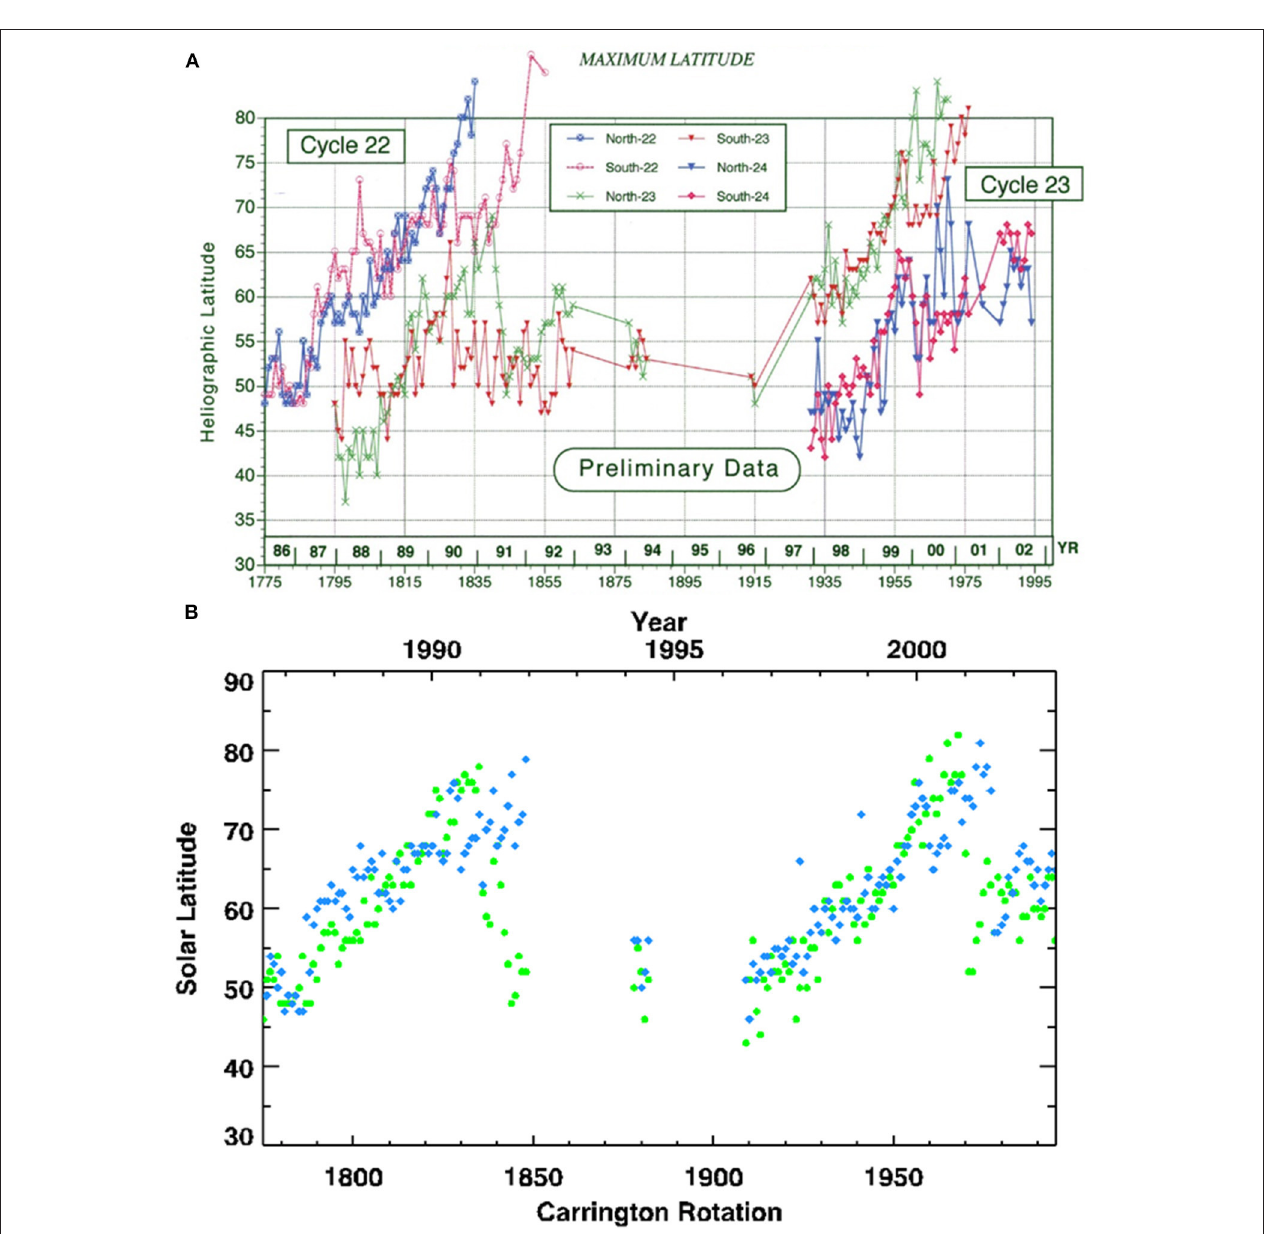
FIGURE 5 | (A) Plot of the maximum latitude per CR for PCFs from original McIntosh maps, including the “secondary” PCF that appears at lower latitudes and replaces the “true” PCF after the solar field reverses. Like the SC 20-22 plot in Figure 2 , P. McIntosh produced this expanded plot in 2003 (Figure 6 in McIntosh, 2003) comparing the “rush-to-the-poles” periods of SC 22 and 23. (B) The current version of this plot for the McA that has been completed to date for SCs 22 and 23. This plots only the single polemost filament location from each CR map, and so does not separate the true and secondary PCF branches as the top plot does. For each SC the northern hemisphere locations are plotted as filled green circles and the southern as filled blue